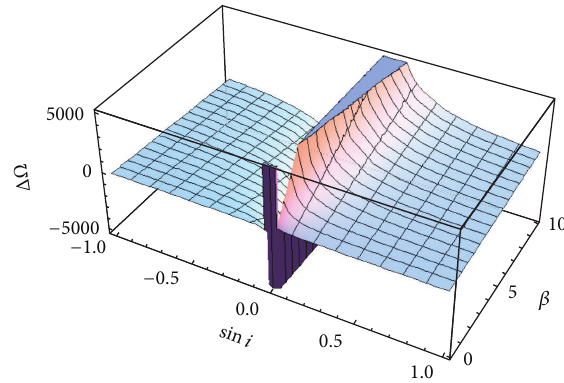
Figure 5: The optimum change in the longitude in the ascending node ΔΩ versus the inclination sin 𝑖 and sail lightness number 𝛽